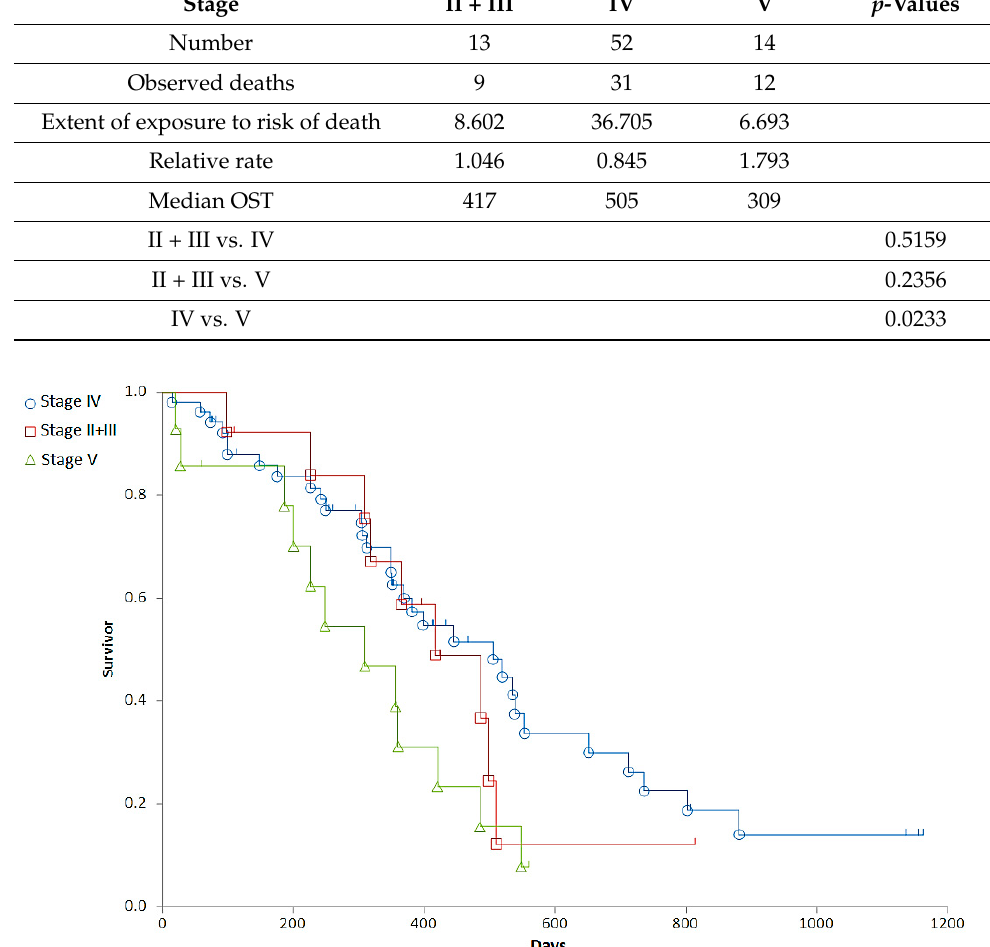
Table 3. Clinical stages of the patients at the time of diagnosis and their median overall survival times. The highest median OST was observed in dogs with Stage IV, which was also the group with the highest number of patients.